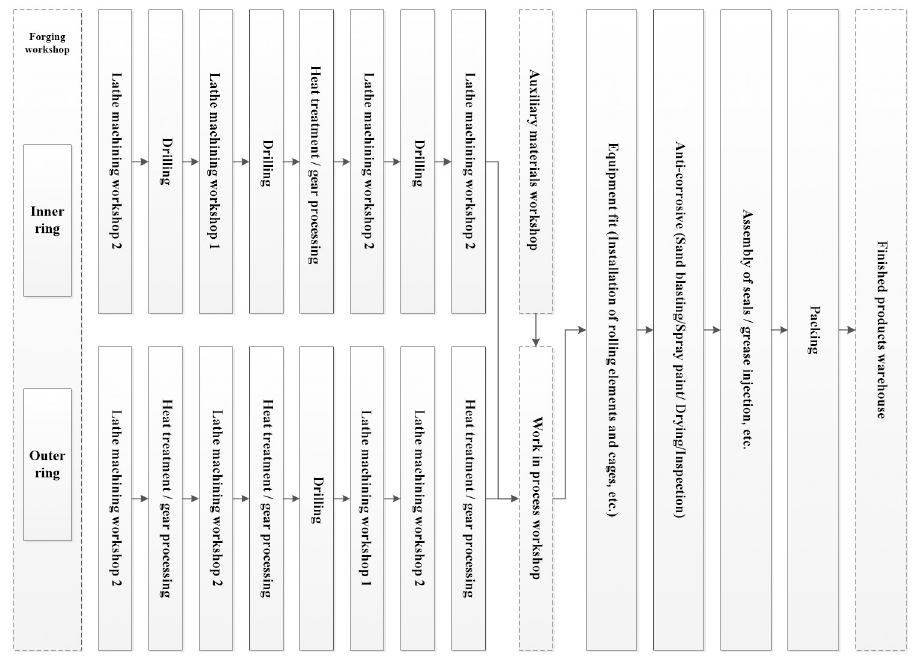
Fig 3. Model of bearing manufacturing process.